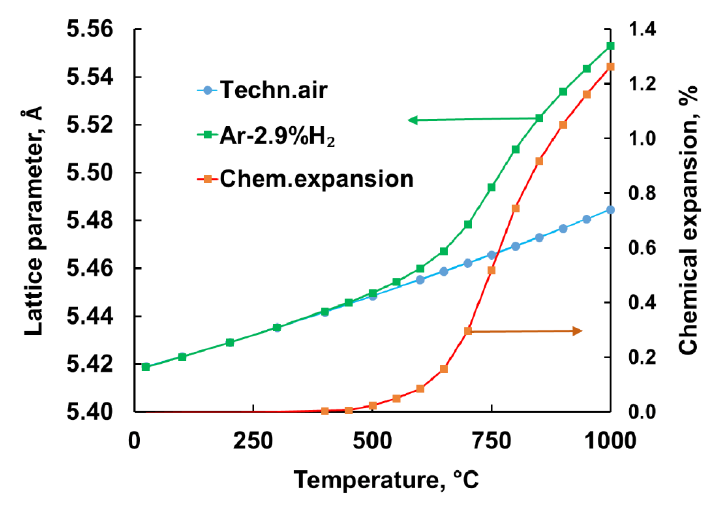
Figure 5. Expansion of GDC10 lattice during heating in synthetic air and in Ar-2.9%H 2 .